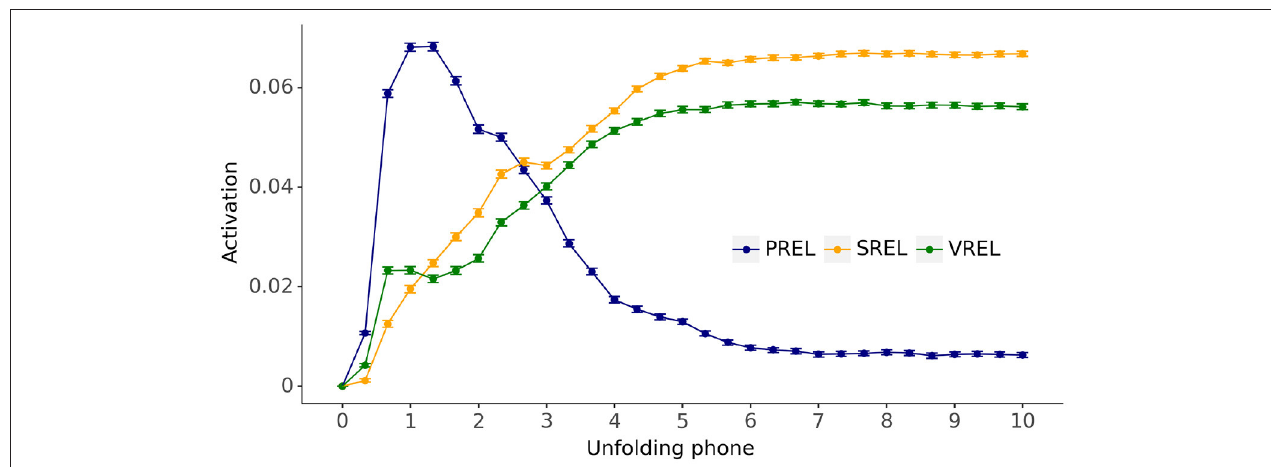
FIGURE 9 | Grand average semantic-visual activation time courses relative to the activation of unrelated distractors (UREL) for phonological candidates (PREL), semantic candidates (SREL), and visual candidates (VREL), evaluated for the fully trained models across all models and simulation trials. Error bars: 95 % confidence